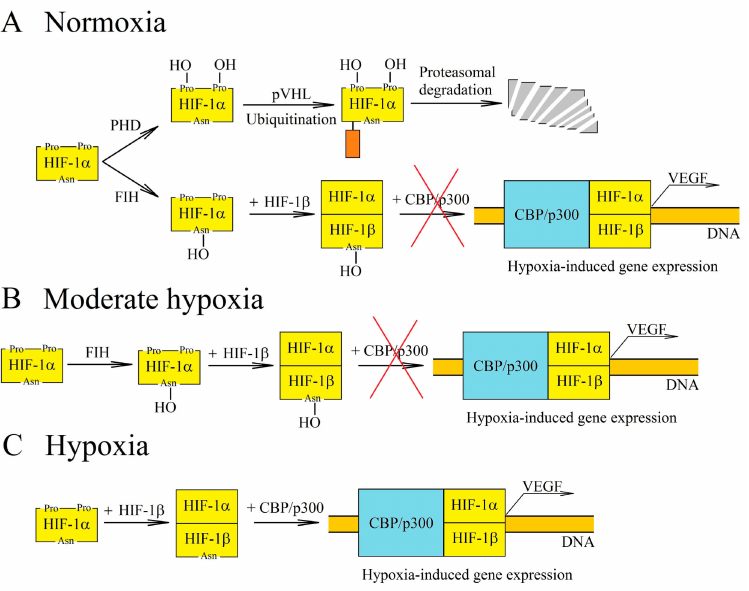
Figure 2. Regulation of hypoxia-inducible factor-1 (HIF-1) transcriptional activity at various oxygen concentrations. ( A ) In normoxia, HIF-1 α is hydroxylated by the oxygen-dependent enzymes prolyl hydroxylase (PHD) and factor inhibiting HIF (FIH). The PHD-catalyzed reaction leads to proteasomal degradation of HIF-1 α . In turn, hydroxylation by FIH prevents interaction of HIF-1 with the CBP/p300 coactivator. ( B ) PHD and FIH require different concentrations of oxygen for their activity and so, in moderate hypoxia, PHD activity decreases while FIH retains its functions. Accumulation of HIF-1 α occurs, but due to hydroxylation by FIH, there is no interaction between HIF-1 and the CBP/p300 coactivator, and thus genes dependent on this coactivator are not expressed. ( C ) In hypoxia, the activities of oxygen-dependent enzymes are reduced. For this reason, HIF-1 α is not hydroxylated by PHD or by FIH. This subunit begins to form a transcription factor with HIF-1 β , which is responsible for inducing the transcription of hypoxia-dependent